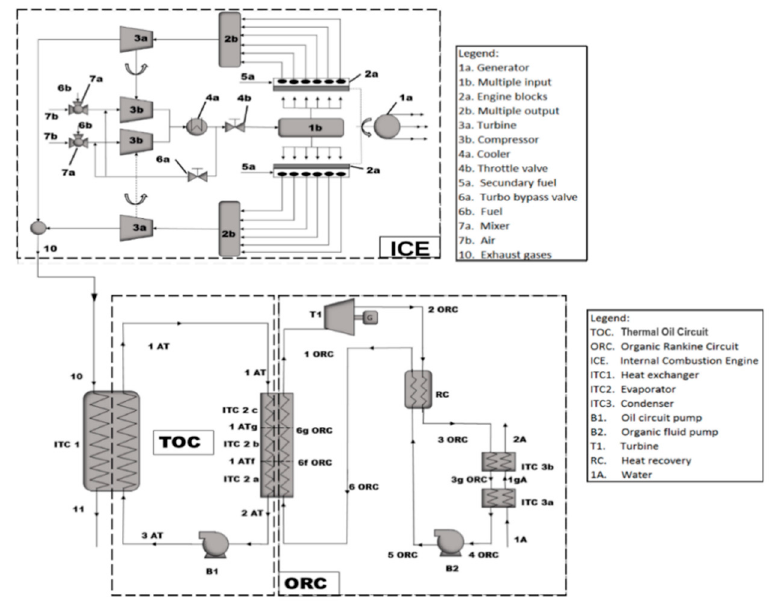
Figure 2. Physical structure of the waste heat recovery configuration based on recuperative organic Rankine cycle (RORC). Table 1. Physical engine parameters and internal combustion engine (ICE) performance indicators. Value Units